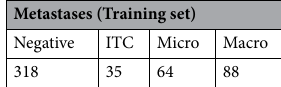
Table 4. Metastases type distribution in CAMELYON17 training